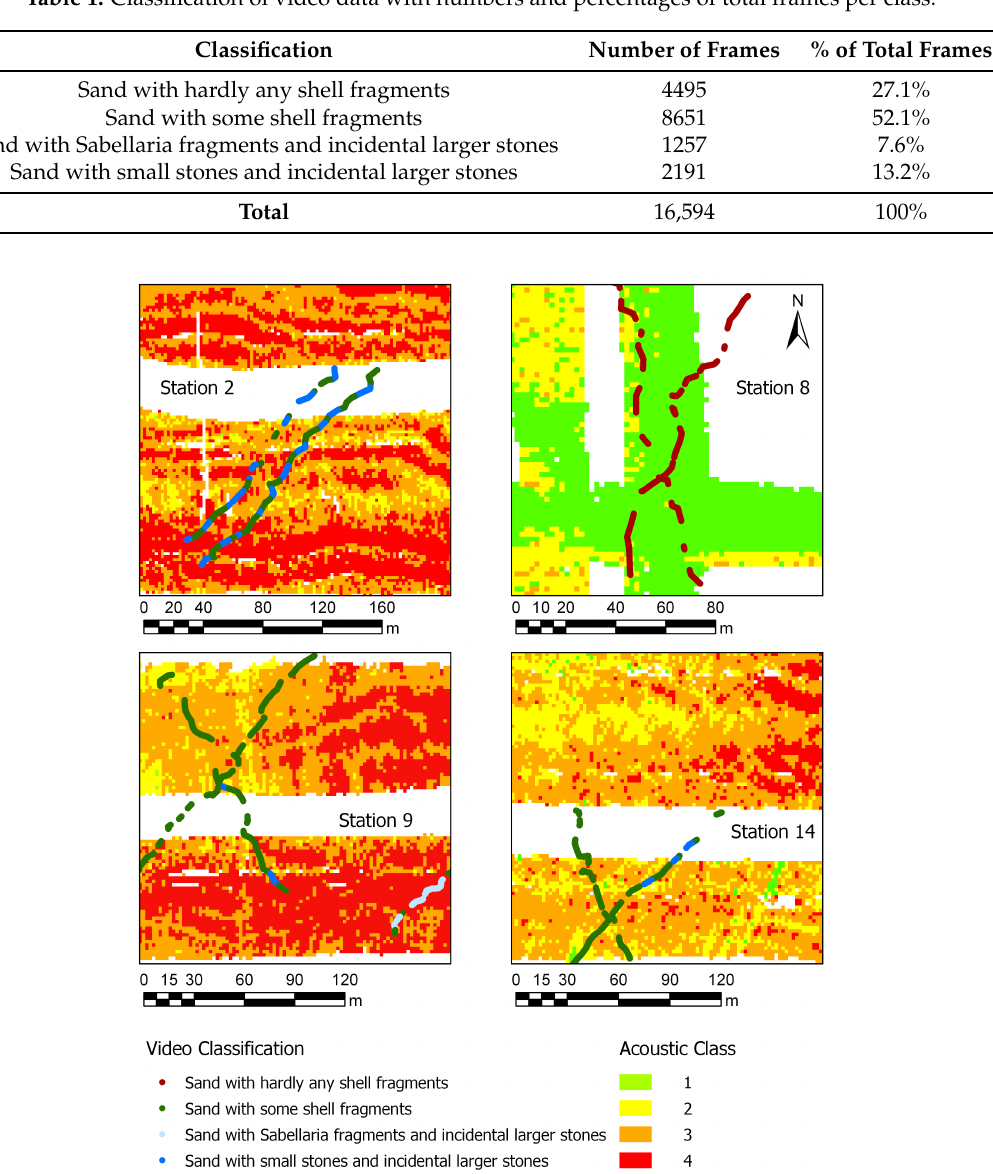
Figure 9. Video classification results at four stations. Per station, indicated location and class of video frame in colored dots and MBES classification results as